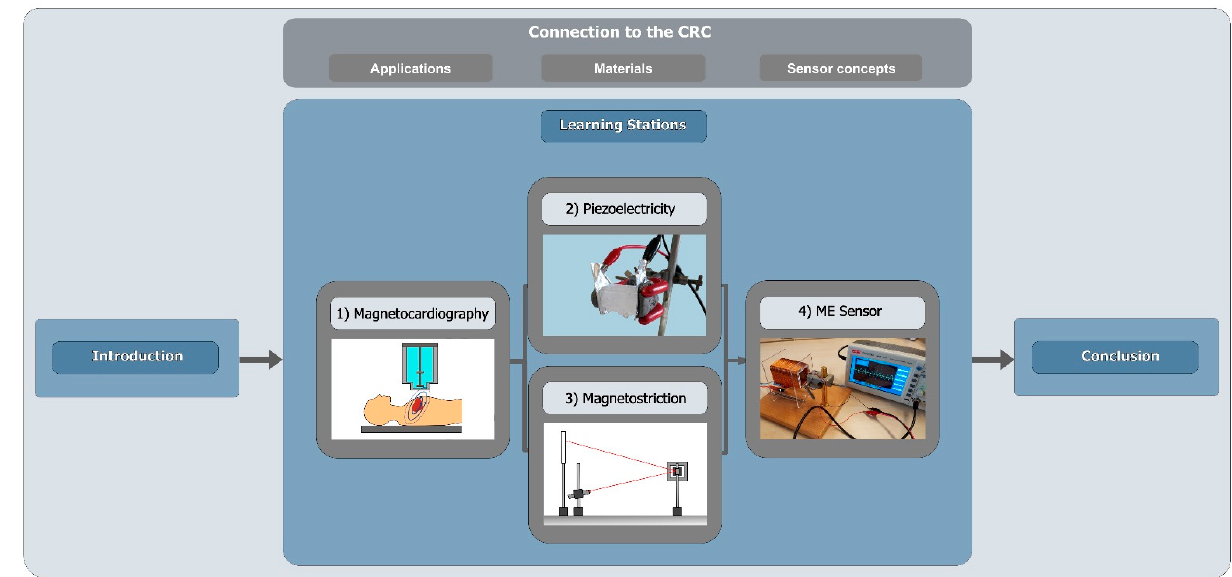
Figure 4. Structure of the project day at the Kiel Science Factory.